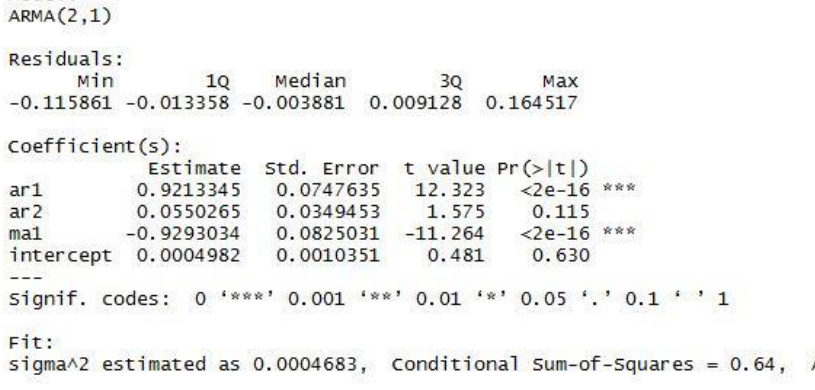
Fig. 3. R output by function arma for Hindalco daily returns